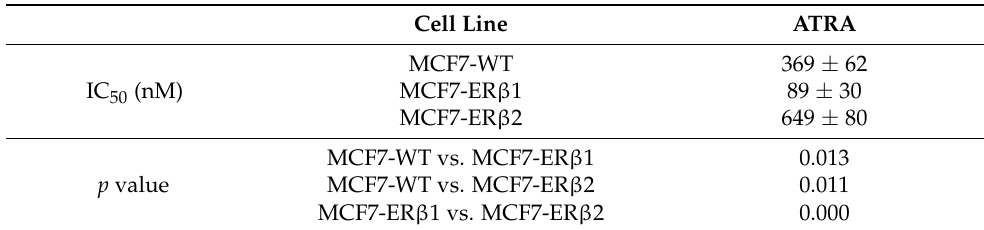
Table 2. IC 50 values of cell response to ATRA as compared using one-way ANOVA. ATRA, all-trans retinoic acid. Cell Line